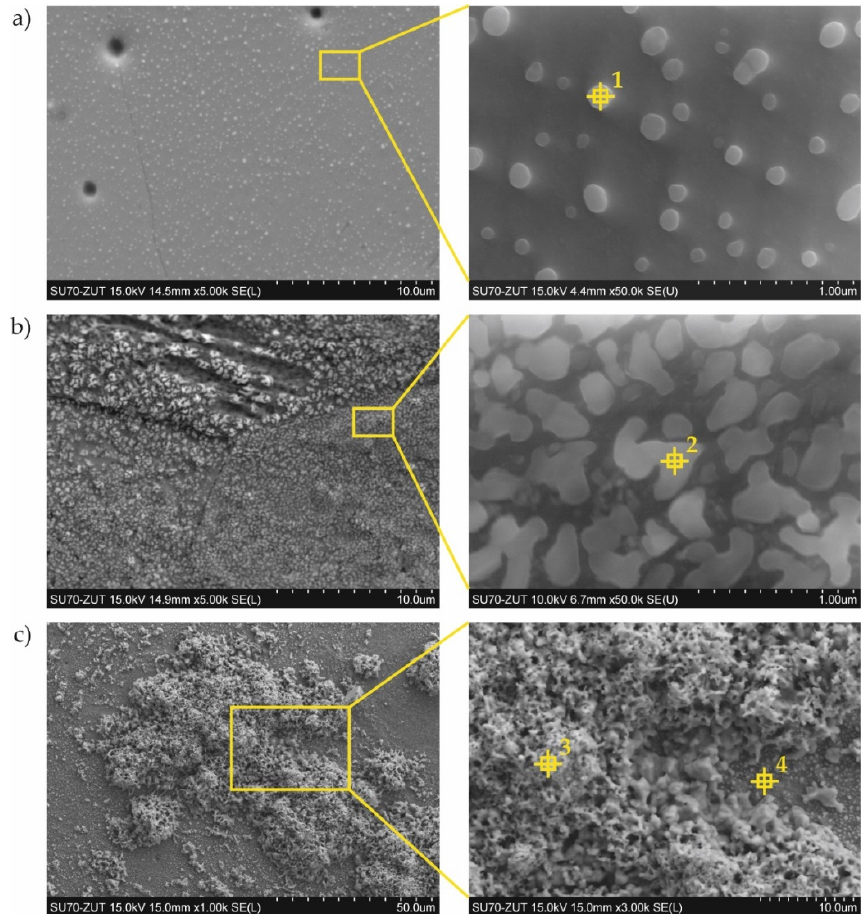
Figure 5. Surface of the uncoated, reference sample of 1.4541 steel after ( a ) 51 h, ( b ) 124 h, and ( c ) 200 h of nitriding. Table 4. The results of the EDS/WDS point analysis of 1.4541 steel according to Figure 5. Point of Analysis